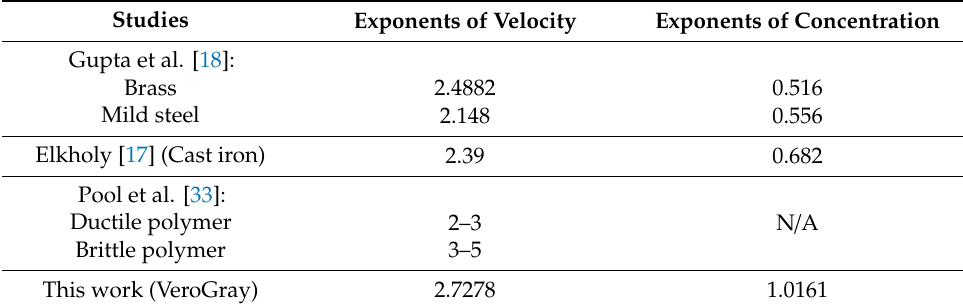
Table 3. Exponents of solids concentration and flow velocity in previous studies and this